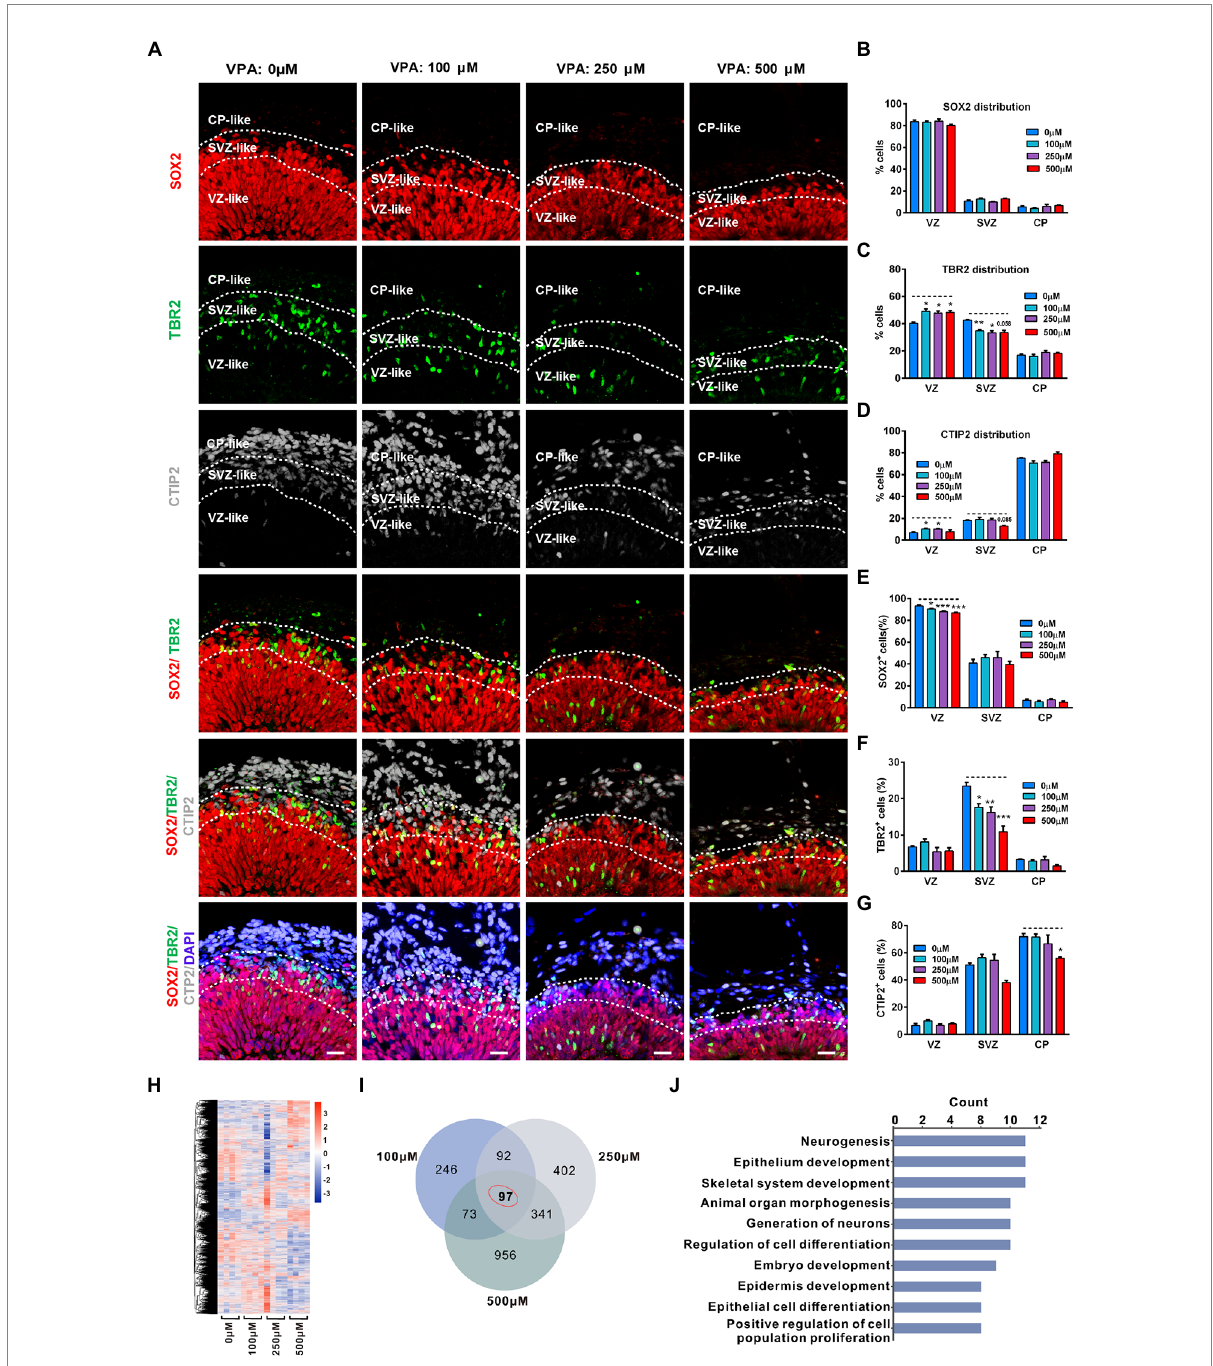
FIGURE 5 VPA exposure decreased abundance of progenitor cells and neurons in human dorsal forebrain organoids at day 56. (A) Representative image of 0, 100, 250, and 500 μ M VPA treated human dorsal forebrain organoids at day 56 (0 μ M, 100 μ M: n = 4 organoids; 250 μ M: n = 5 organoids; 500 μ M: n = 3 organoids). The defined VZ, SVZ, and CP-like regions are delineated according to the combination of DAPI, SOX2, TBR2, and CTIP2 staining patterns. Scale bars, 20 μ m. (B–D) Analysis of marker allocation across the VZ/SVZ/CP within the organized regions in 0, 100, 250, and 500 μ M VPA treated human dorsal forebrain organoids. (E–G) Analysis of the percentage of SOX2 + , TBR2 + , and CTIP2 + cells out of total cells in the examined areas. Scale bars, 20 μ m. (H) Hierarchical clustering heatmap for DEGs from the organoids of control (0 μ M) and VPA treated organoids (100, 250, and 500 μ M) on day 56 ( n = 4 organoids each). (I) Venn diagram of co-regulated DEGs by VPA. (J) Enriched top 10 GO pathways in biological process. * p > 0.05, ** p > 0.01, *** p >